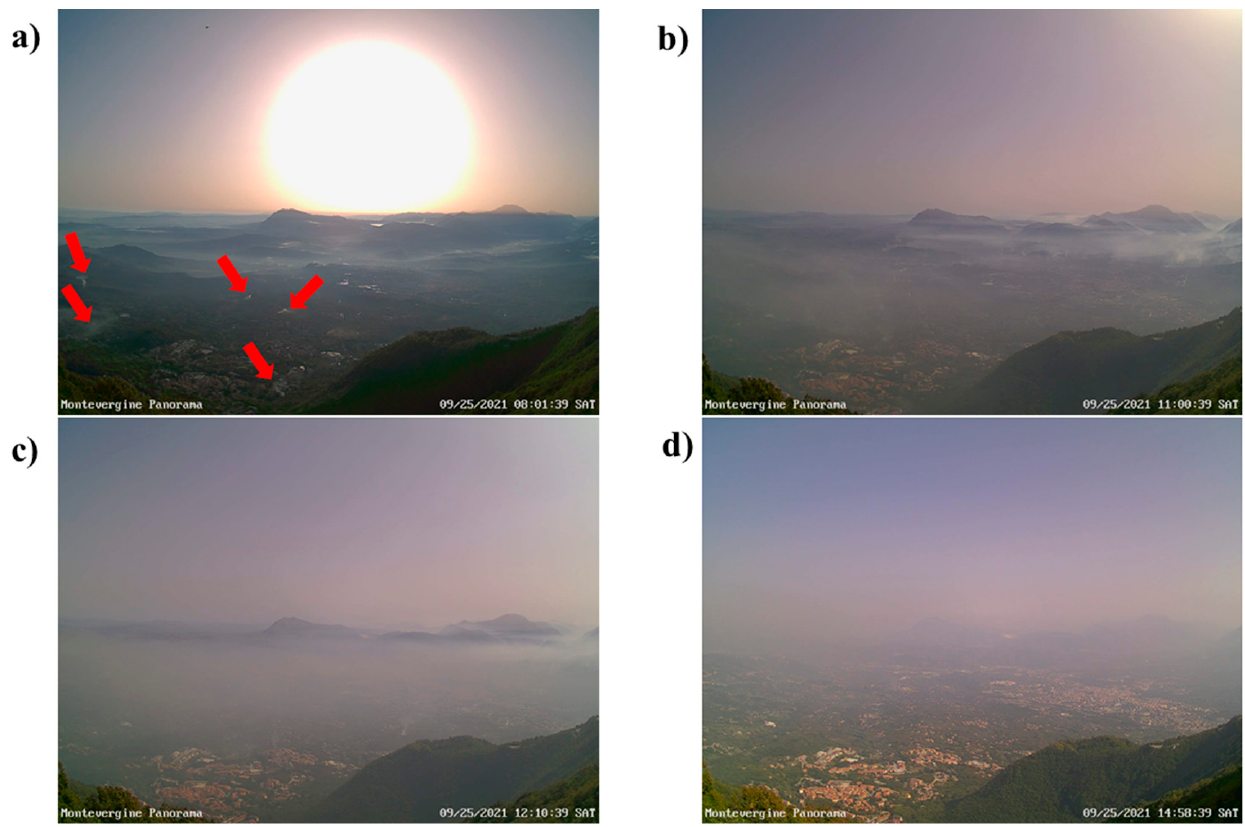
Figure 10. Sequence of pictures of the Sabato Valley taken at Montevergine observatory (MO) during 25 September 2021 at different hours (8:01 a.m. ( a ), 11:00 a.m. ( b ), 12:10 p.m. ( c ) and 2:58 p.m. ( d )). The red arrows in the panel ( a ) mark some smoking areas associated with biomass burning.